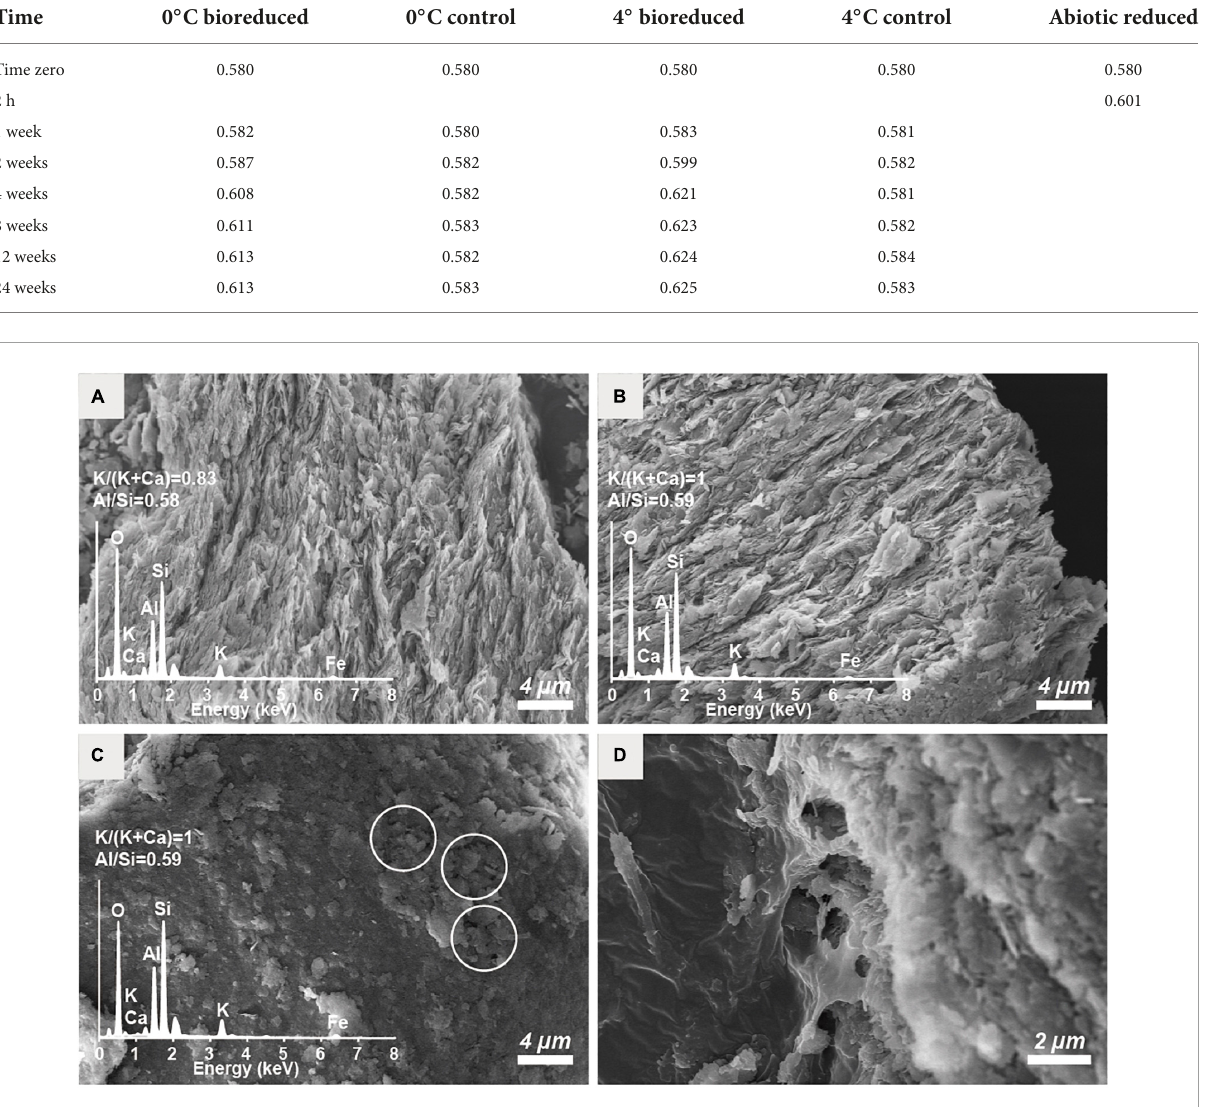
FIGURE4 SEM images of the (A) unaltered initial IMt-1, (B) chemically reduced IMt-1, (C) bioreduced IMt-1 after 24 ◦ weeks incubation, and (D) magnification of dissolution pits in bioreduced